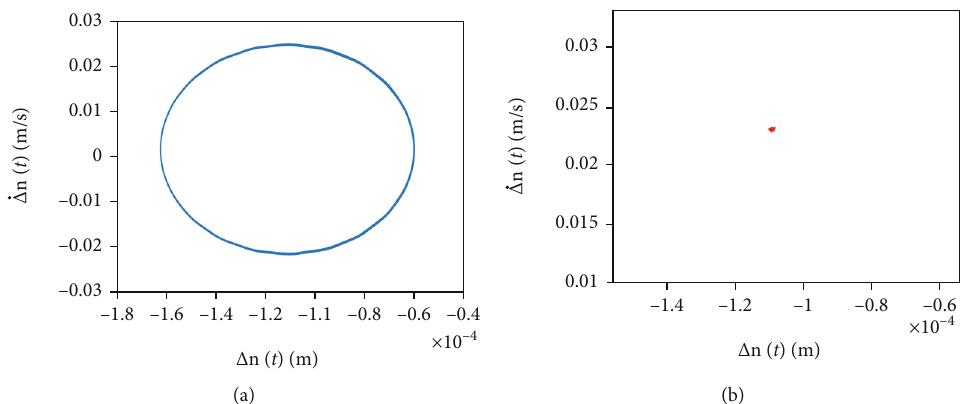
Figure 26: When the rotation speed of the system is 4300r/min: (a) relative displacement velocity and (b) the corresponding diagram of Poincare.